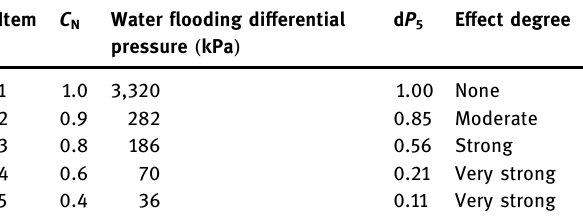
Table 6: Fracture plugging performance of polymer gel at di ff erent leak o ff degrees ( W f = 5 mm